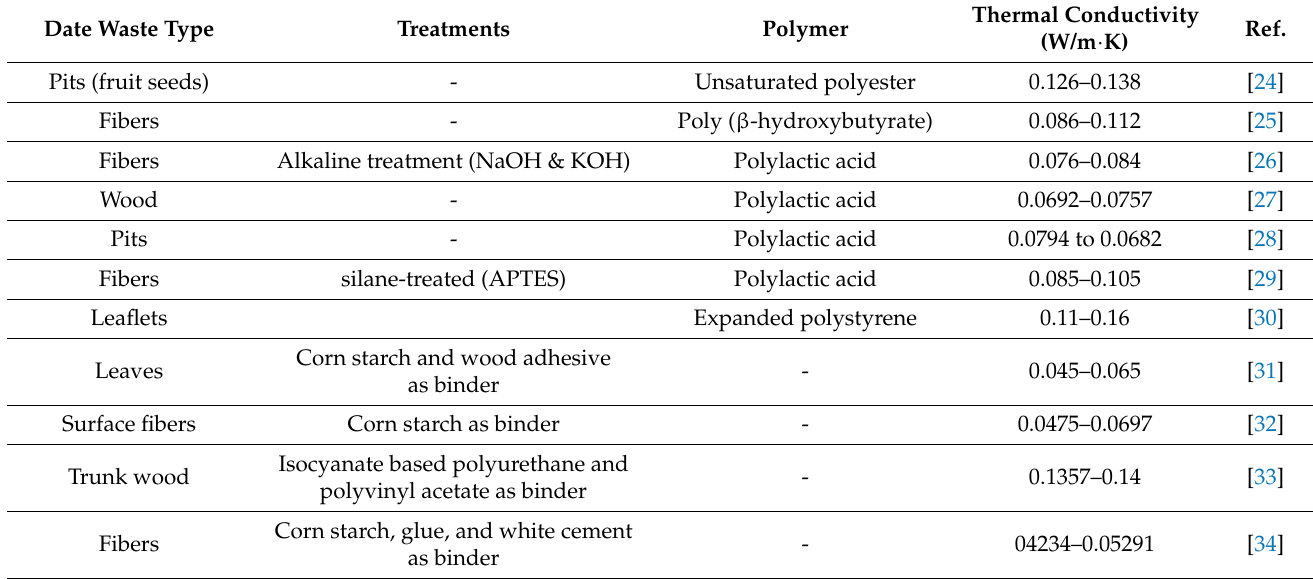
Table 1. Date palm waste-based